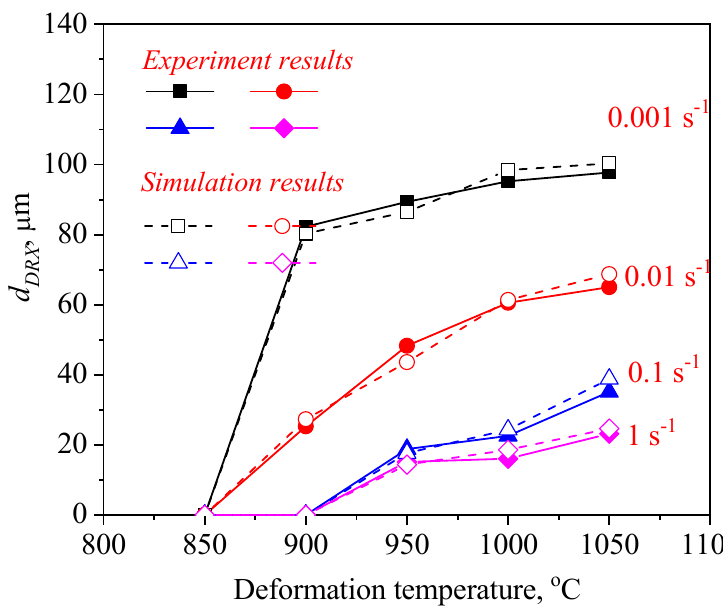
Figure 15. Microstructure of the 47Zr-45Ti-5Al-3V alloys after hot-working and CA simulation result: ( a,e ) 900 °C/10 −3 s −1 ,